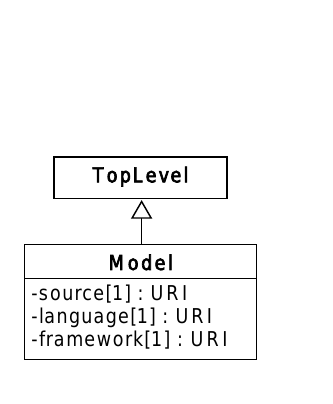
Figure 19: Diagram of the Model class and its associated